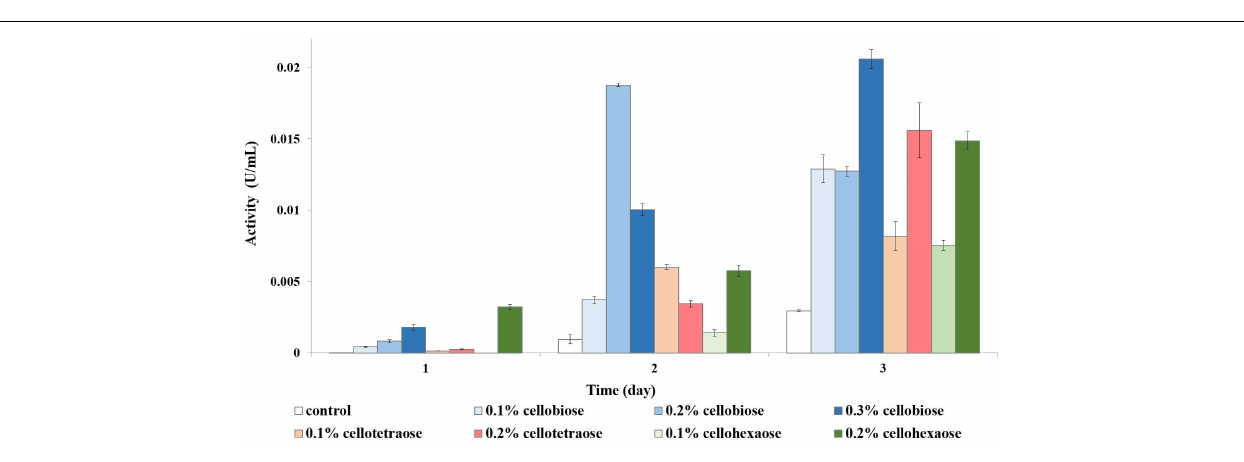
( Figure 11 ). Cellotetraose was rapidly degraded to cellobiose, which was then completely consumed after 1 (0.1% cellotetraose) ( Supplementary Figure S6 ) and 3 h (0.2%